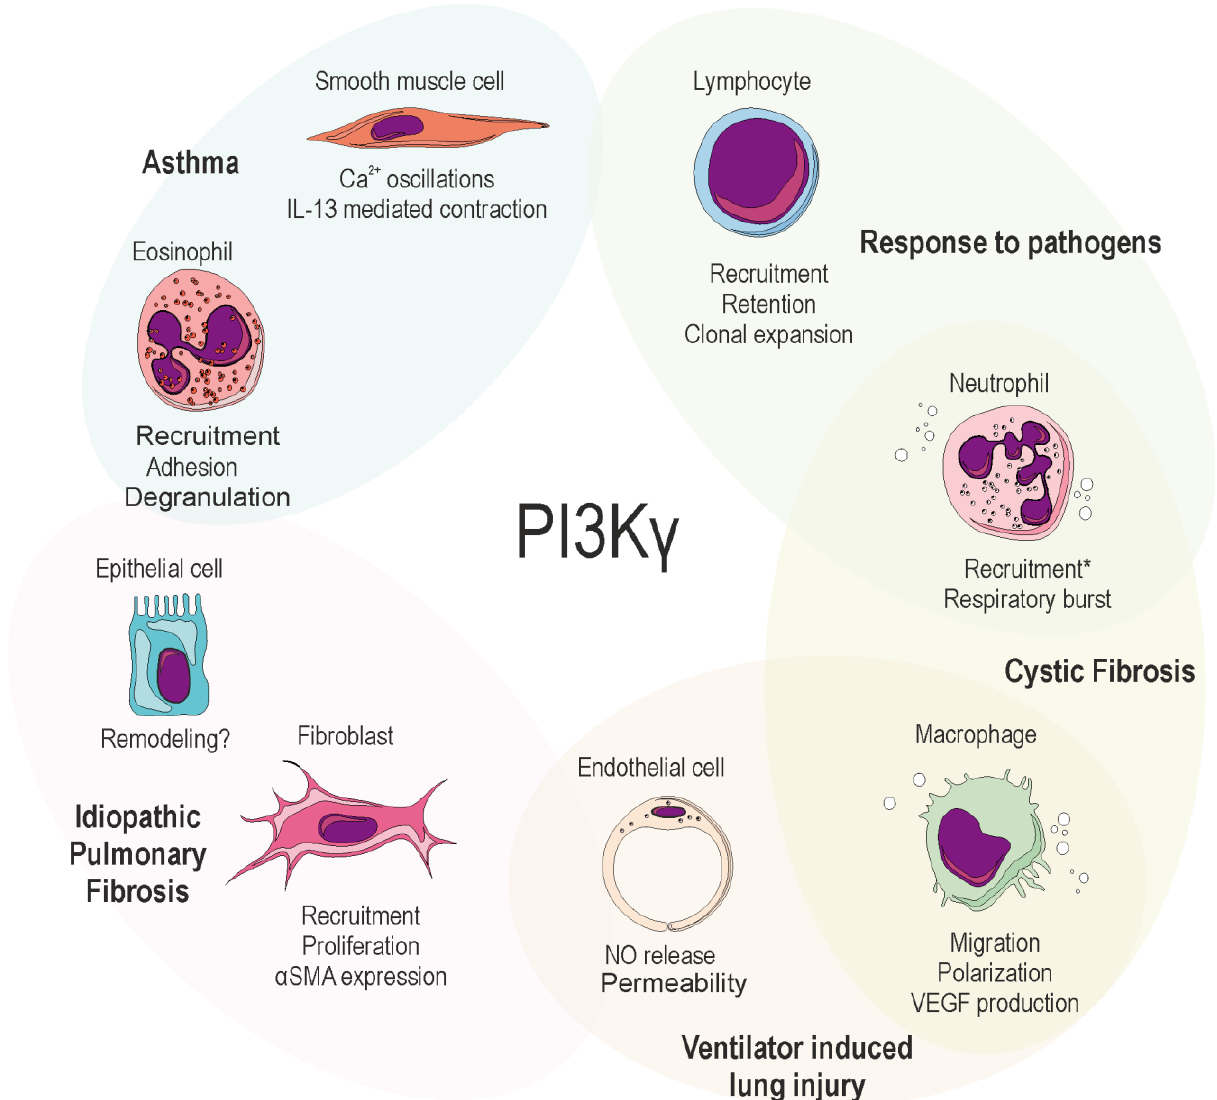
FIGURE 1: Schematic representation of the biological processes induced or mediated by PI3Kγ in the cell types that are releva nt for respira- tory disease. PI3Kγ has been involved in almost all target cells shown in the figure using either isoform-selective PI3K inhibitors or genetic engineering. *Neutrophilic recruitment may be enhanced by either activation or inhibition of PI3Kγ, depending on the context. NO: Nitric Oxide; αSMA: α -smooth muscle actin; VEGF: Vascular endothelial growth factor; IL-13: